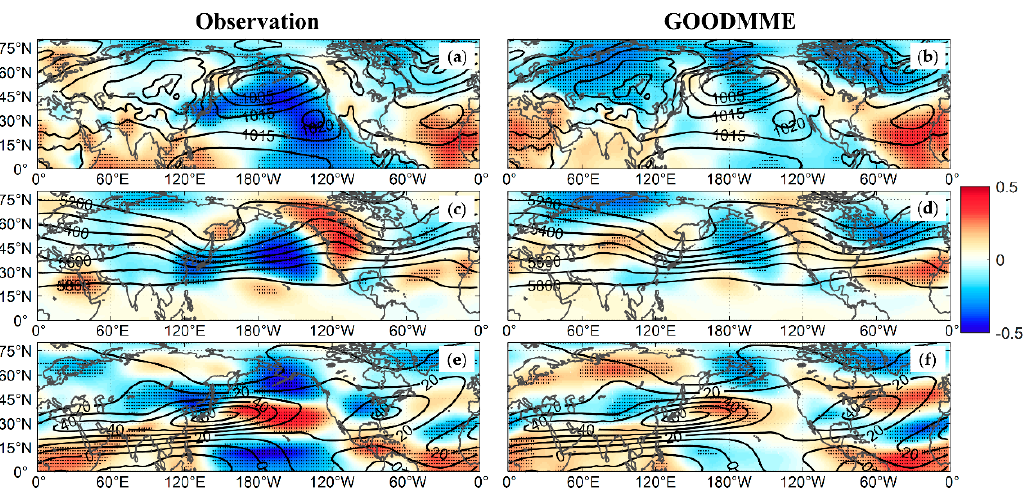
Figure 7. Correlation maps of the monthly PDO and ( a , b ) the SLP, ( c , d ) the geopotential height at 500 hPa, and ( e , f ) the zonal wind at 200 hPa during winter over 1901–2005 (black points mean that the coefficient is statically significant at 90%; contours are the average values over 1901–2005; and the intervals are ( a , b ) 5 hPa, ( c , d ) 100 m, and ( e , f ) 10 m/s). ( a ), ( c ), and ( e ) correspond to HadISST and ( b ), ( d ), and ( f ) correspond to the GOODMME.